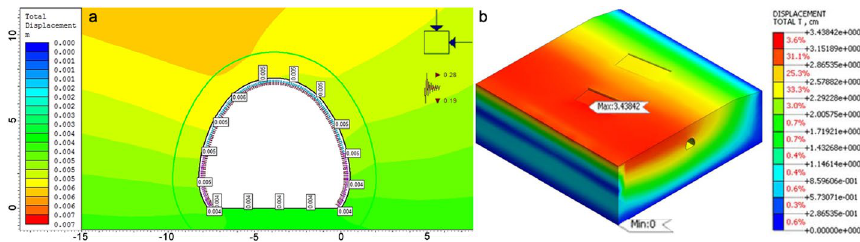
Fig. 15 Total displacement in 2D and 3D numerical analysis for pseudo-static conditions ( a : 2D Rocscience Phase 2D V8.2), b : 3D (Midas GTS NX) were performed by Emre Ozcan Engineering and Prohit Engineering [22,